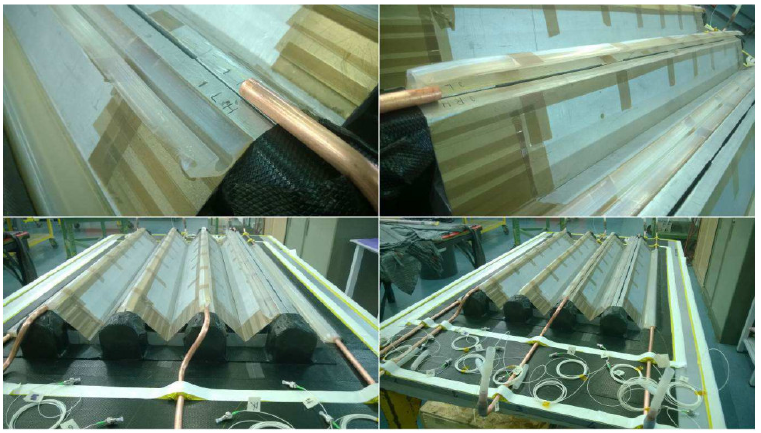
Figure 10. Stringer sensorization with Ω opened.